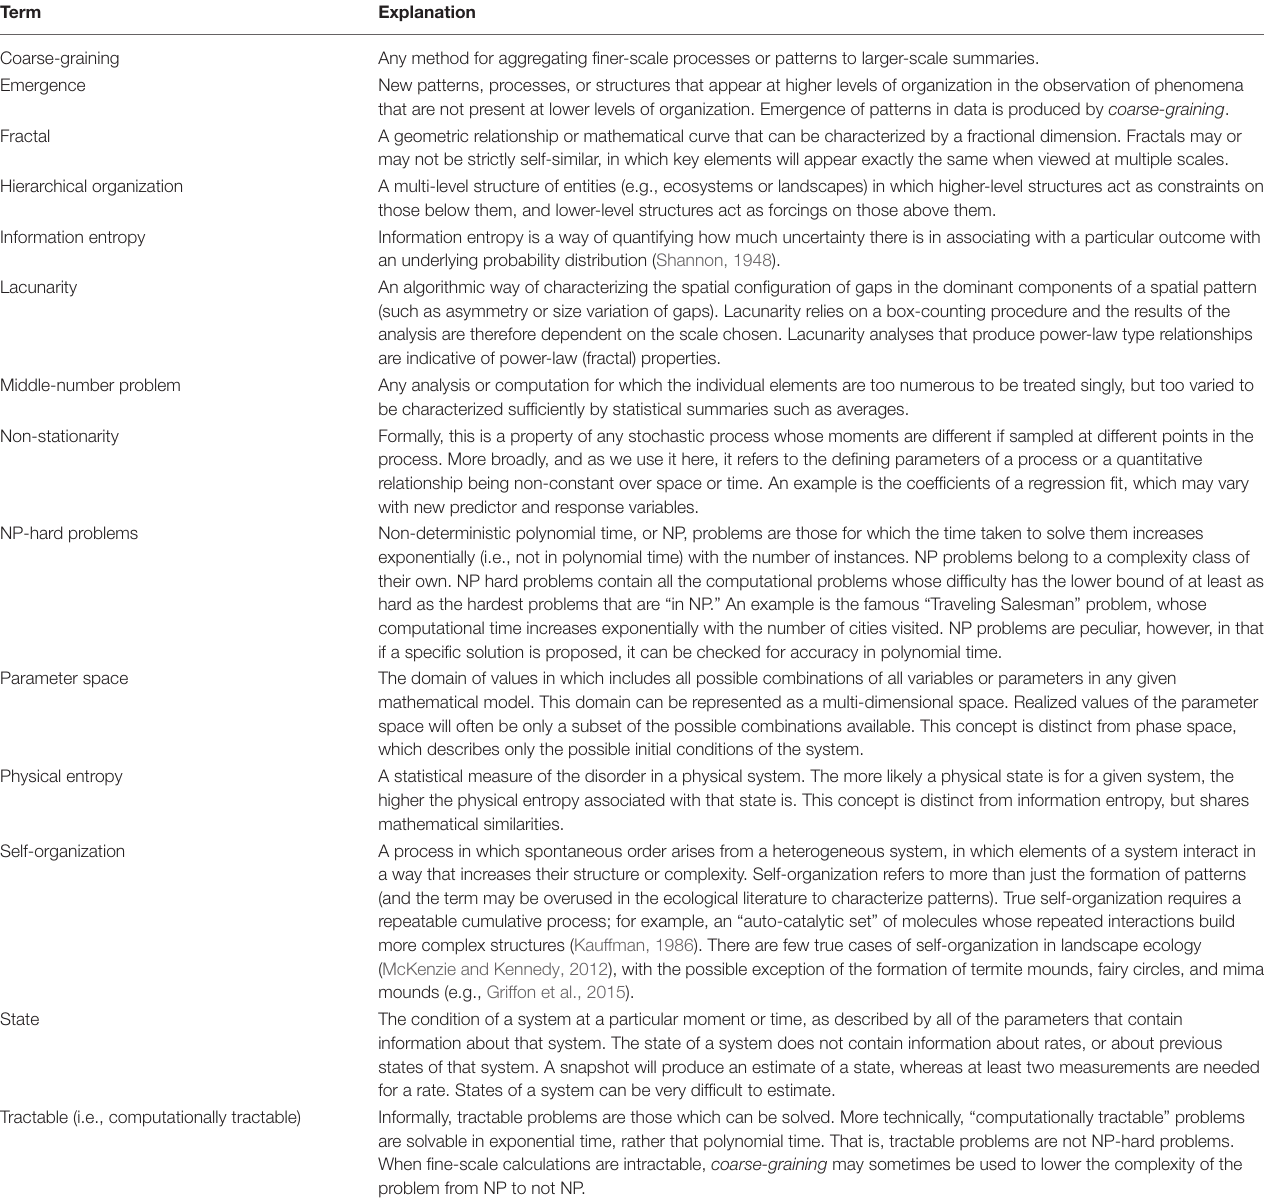
TABLE 1 | Common terms in complexity science, as related to landscape complexity.